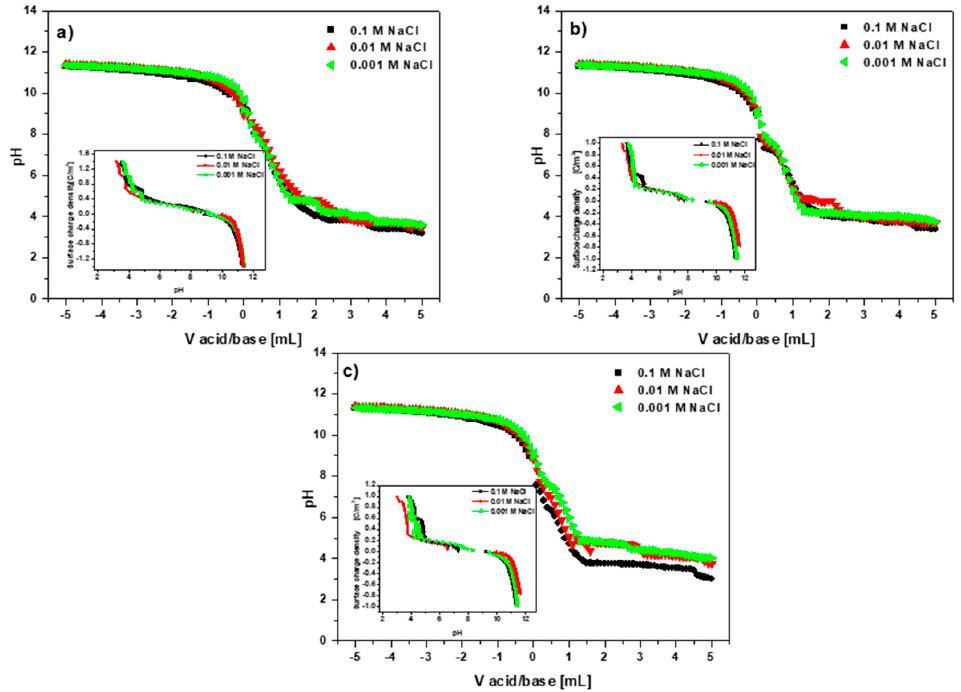
Figure 8. Point of zero charge and dependence of the surface charge density as a function of pH determined by the potentiometric method: ( a ) BC-CS 1–1, ( b ) BC-CS 2–1 and ( c ) BC-CS